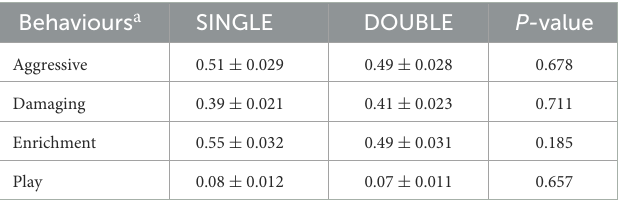
TABLE 7 Differences (LS means ± SE) between treatments of the frequency of behaviors per pig recorded during direct observation of behavior at pen level over a 5-min